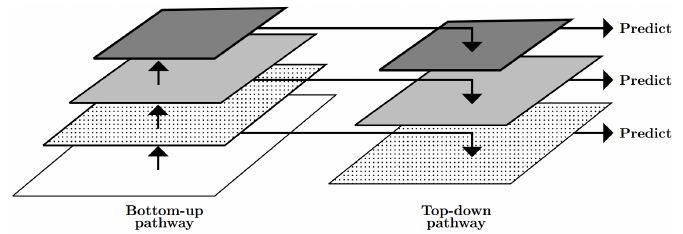
Figure 2. Schematic representation of the Feature Pyramid Network